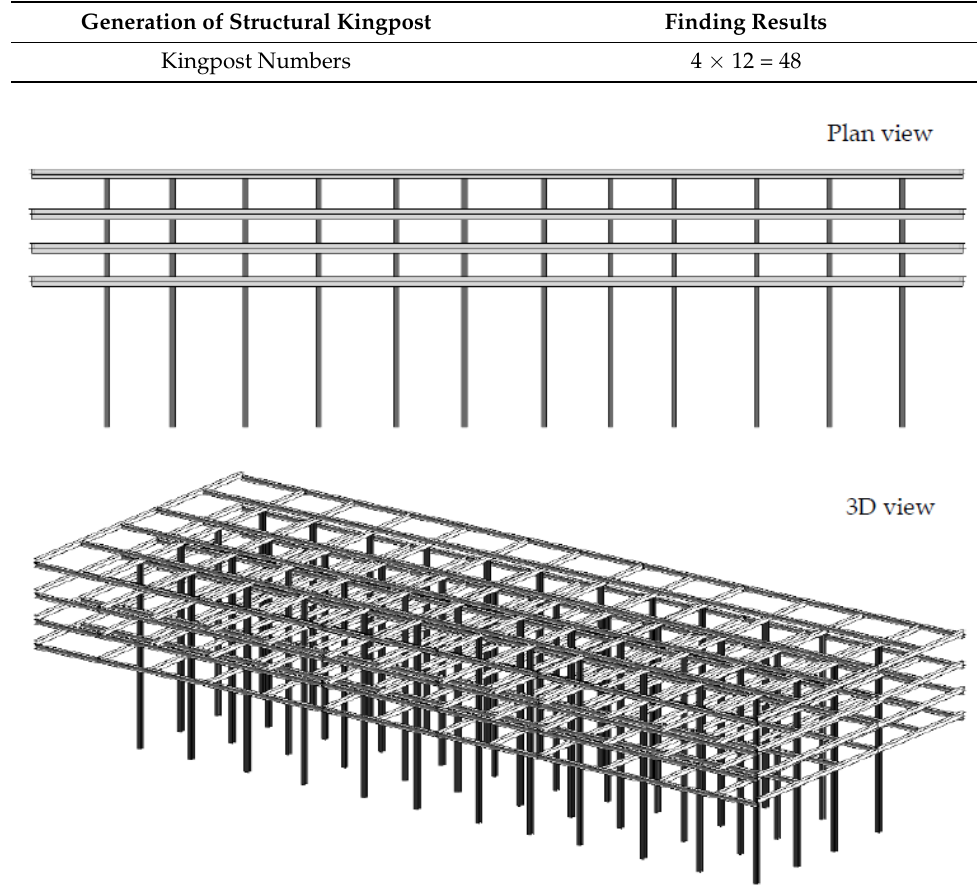
Figure 18. An initial structural kingpost generation in plan and 3D views.